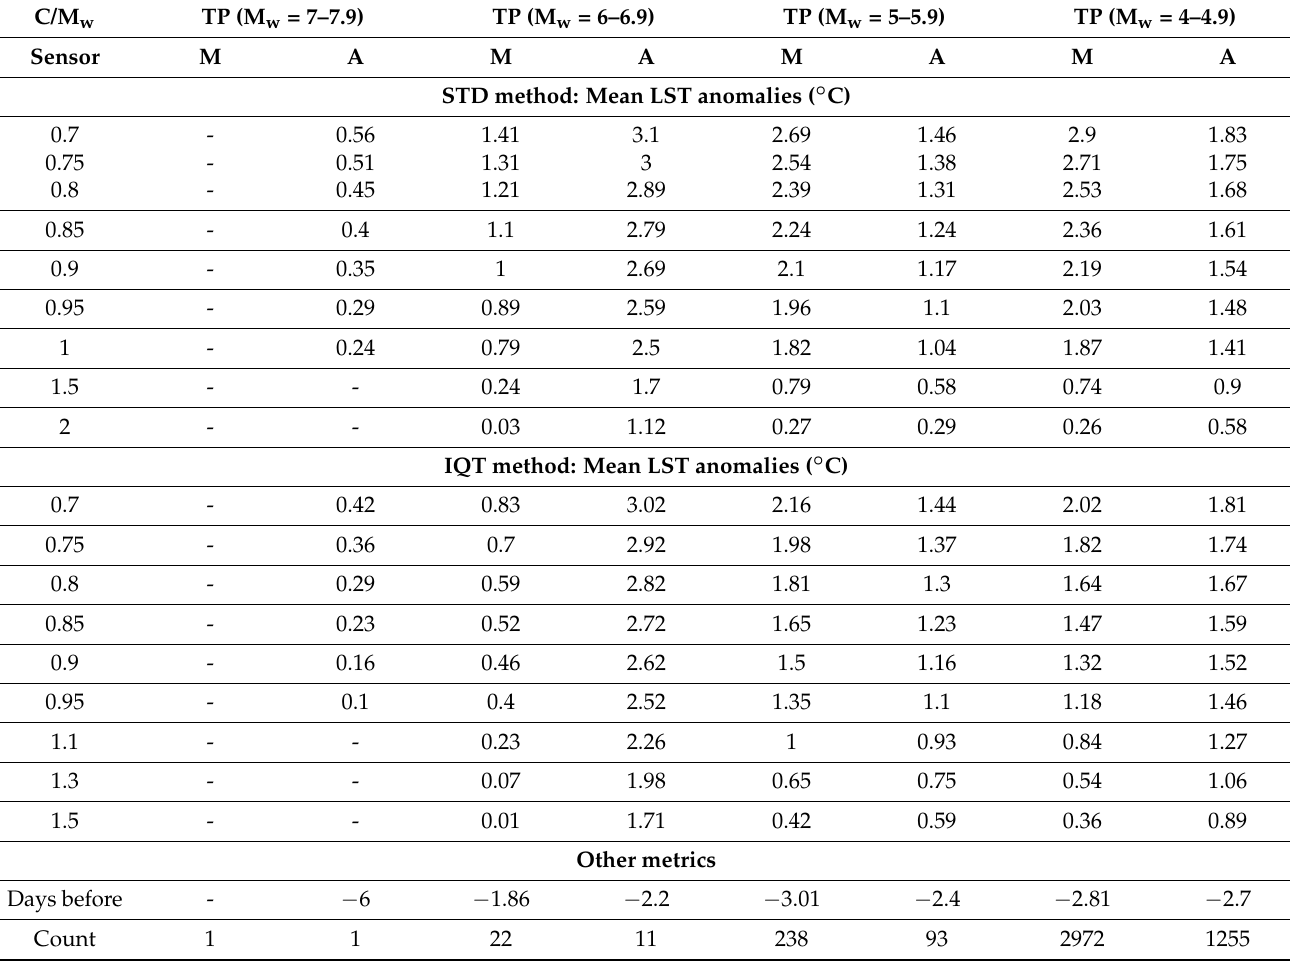
Table 5. Average LST Anomalies ( ◦ C) for TP as a Function of Mw and